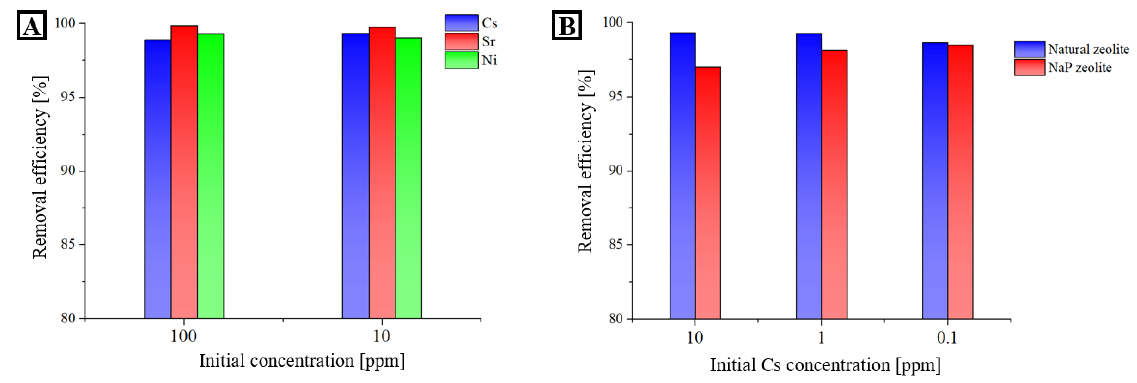
Figure 7. Batch sorption results of zeolites with the solid to solution ratio of 100mL/g. ( A ): removal efficiency of granular- sized NaP zeolite in Hanbit groundwater with 100 and 10 ppm of Cs + , Sr 2+, and Ni 2+ . ( B ): Batch sorption data for the removal of Cs + with granular-sized natural zeolite and NaP zeolite at various concentrations in groundwater collected around the Hanbit NPP site. (Error bar was omitted because of too small range).